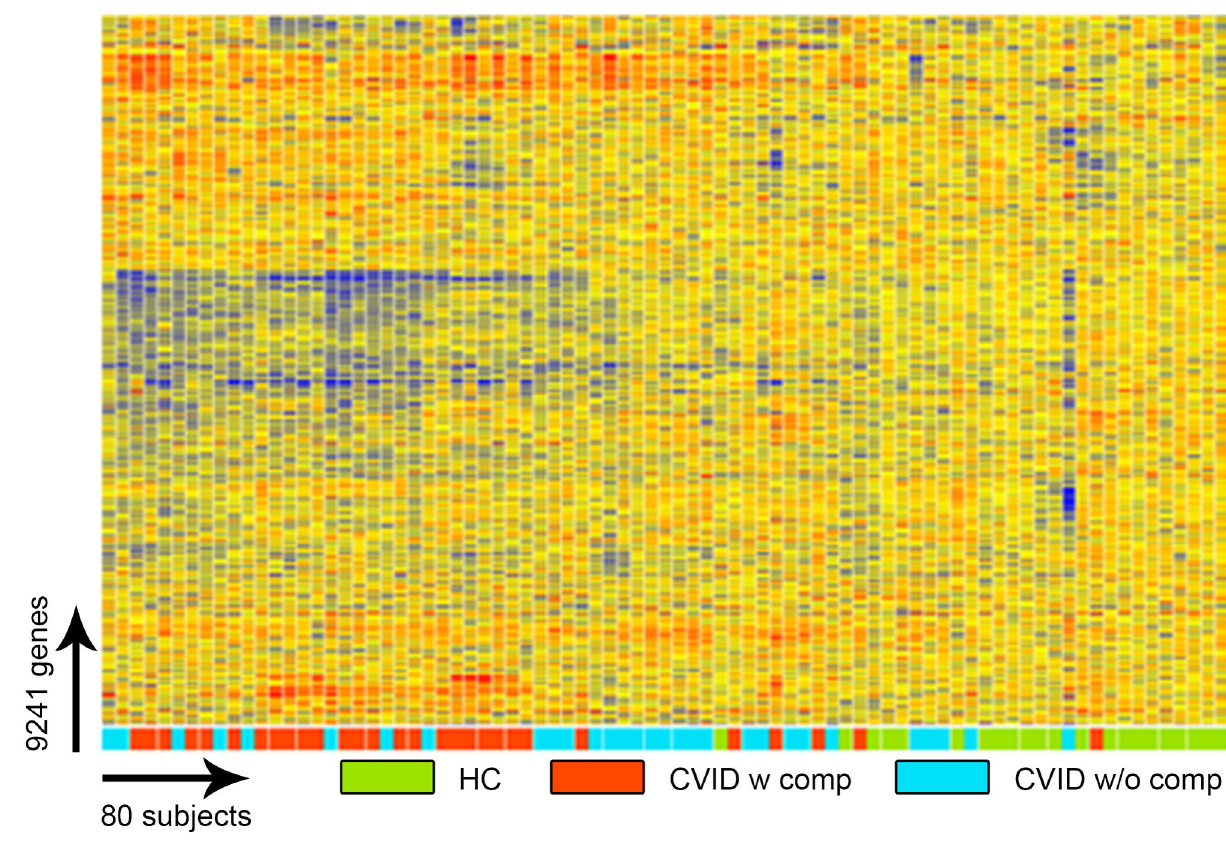
Figure 1. Gene expression analysis of CVID blood (training set) compared to healthy controls. Unsupervised clustering of 9,241 RNA transcripts expressed in whole blood cells selected by Present At least Once (PALO), differentiates CVID patients from healthy controls in the training